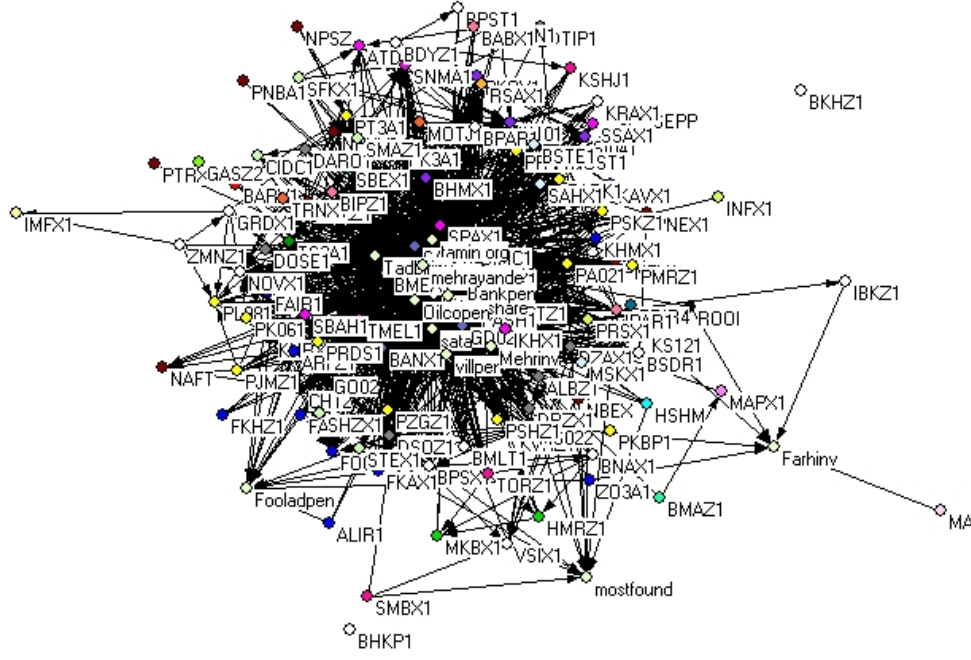
Figure 7. Representation of the cross-shareholding network of Tehran Stock Exchange based on the integrated ownership matrix.